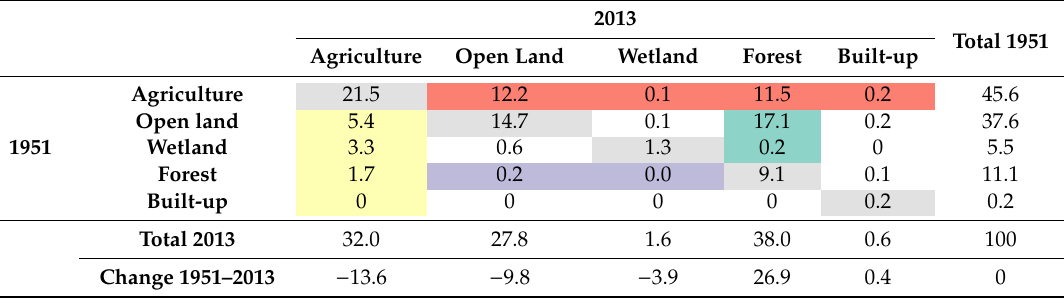
Table 3. Land cover changes [% of total area] in Havrå Cultural Heritage Environment 1951–2013, summarised into five main land types. Grey signifies areas that have the same land type in both years. Red shows areas that were used for agriculture in 1951 but have been converted to other land types in 2013. Yellow shows the opposite change, conversion to agriculture. Green shows forestation of unmanaged open land or wetlands, whilst purple shows the opposite change (see also Figure 3). 2013 Total 1951